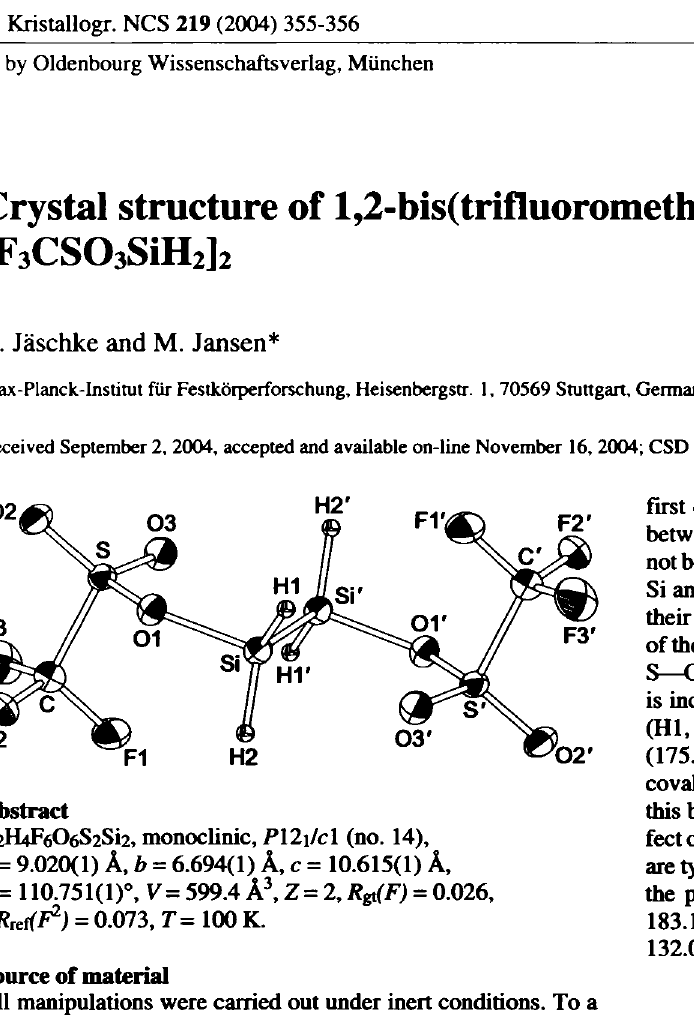
Table 1. Data collection and handling.